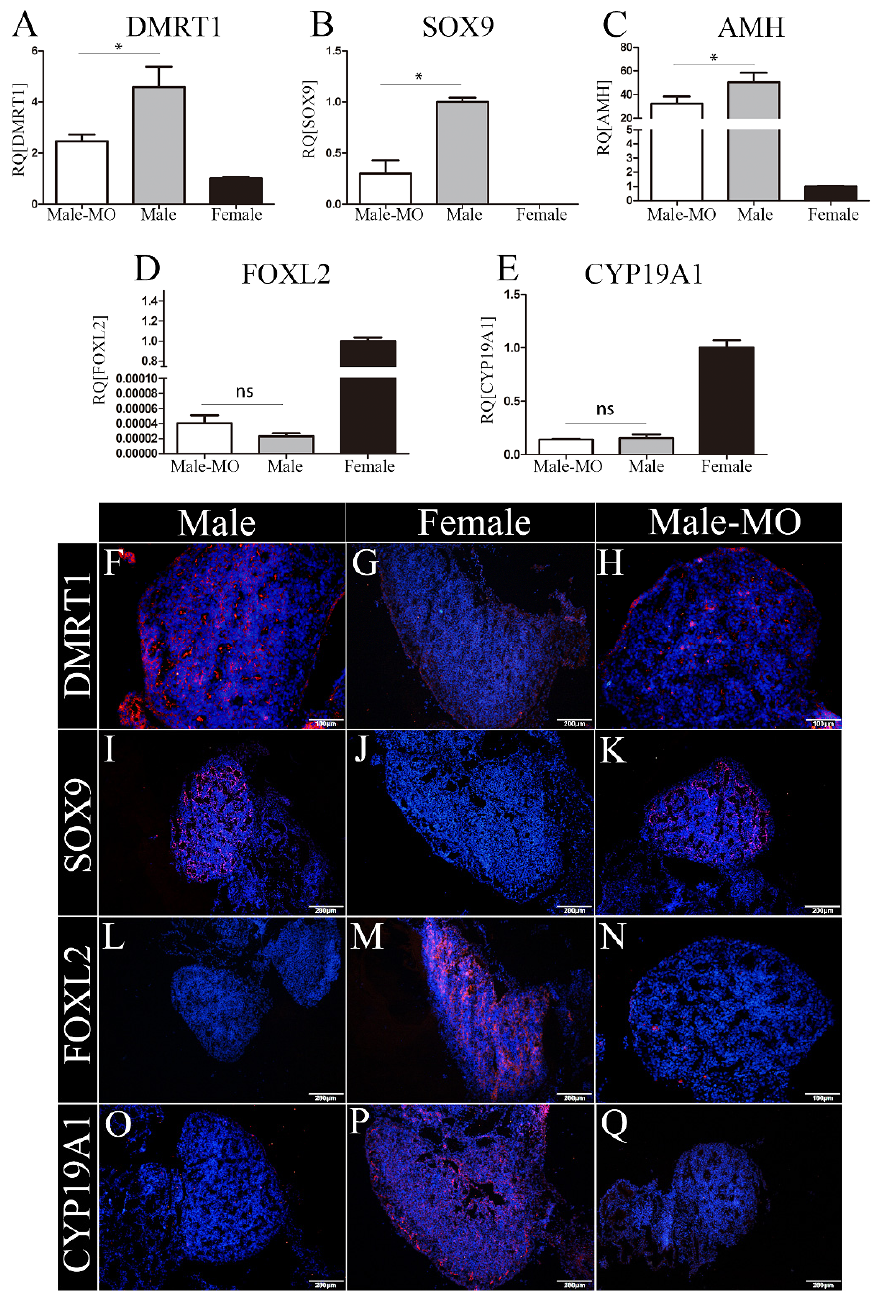
Figure 5. Expression of genes related to gonad differentiation at E10 after miR-2954 inhibition. ( A – E ), Q-PCR results of DMRT1 , SOX9 , AMH , CYP19A1, and FOXL2 , respectively. Error bars show standard error of the mean (SEM) from at least three biological replicates in each group. Asterisks indicate statistical significance: * p < 0.05; ns means no significant difference. ( F – Q ) Immunofluores- cence results of DMRT1, SOX9, FOXL2, and CYP19A1, respectively, in male, female, and VMO-treated male gonads. Blue fluorescence shows DAPI, which marks the nucleus; Red fluorescence indicates expression of sex markers. Scale bar as is shown in picture, thickness = 10 µ m. M-MO indicates male chicken embryo treated by